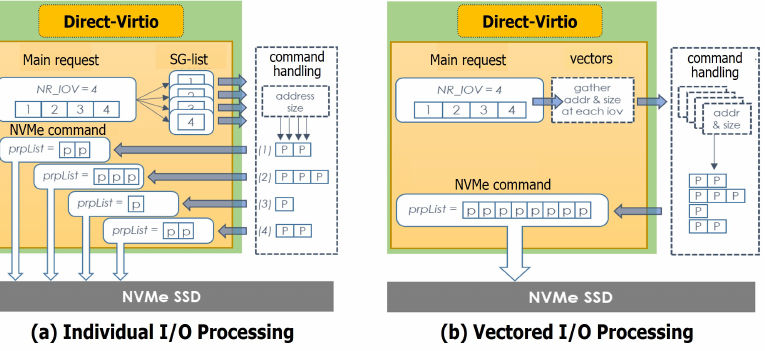
Figure 4. VectoredI/O mechanism: It processes multiple I/Os using a single NVMe